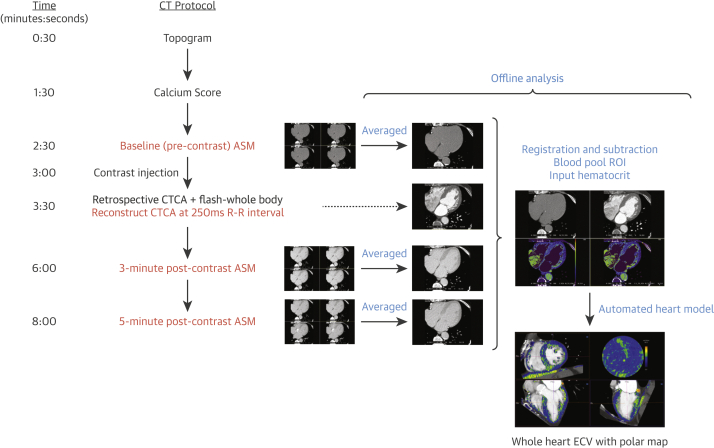
ECVCT Protocol and Offline Analysis Integrated Into TAVR Planning Cardiac CTText in red represents additional image acquisition/reconstruction in scanning protocol for the extracellular volume quantification by computed tomography (ECVCT). Text in blue represents steps in off-line analysis. ASM = axial shuttle mode; CT = computed tomography; CTCA = computed tomography coronary angiography; ECV = extracellular volume; ROI = region of interest.